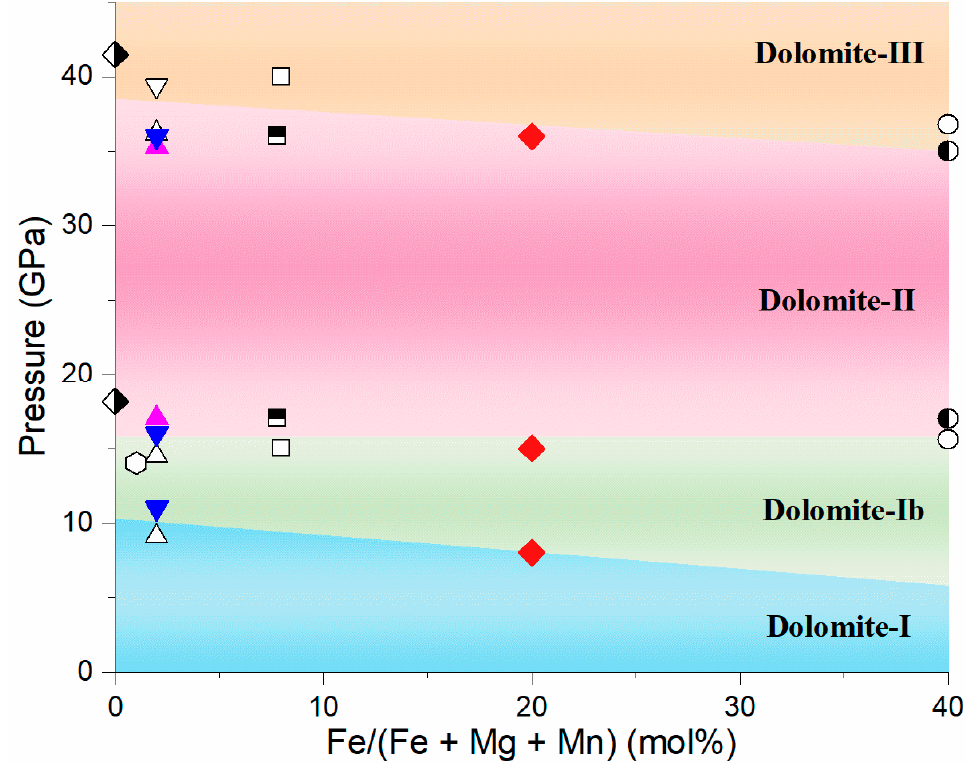
Figure 7. Phase transitions of dolomite as a function of iron content. The cyan, green, magenta, and yellow areas represent the dolomite-Ib, -II, -III phases . Solid red diamonds, : Ca 1.02 Mg 0.76 Fe 0.20 Mn 0.02 (CO 3 ), this study; half open and half solid black diamonds, : CaMg(CO 3 ) 2 [28]; open black hexagon, : Ca 1.001 Mg 0.987 Fe 0.01 Mn 0.002 (CO 3 ) 2 [52]; open black up triangles, : CaMg 0.98 Fe 0.02 (CO 3 ) 2 [25]; open black down triangle, : CaMg 0.98 Fe 0.02 (CO 3 ) 2 [24]; solid magenta triangles, : CaMg 0.98 Fe 0.02 (CO 3 ) 2 [24]; half open and half solid black squares, : Ca 0.988 Mg 0.918 Fe 0.078 Mn 0.016 (CO 3 ) 2 [27]; open black squares, : CaMg 0.92 Fe 0.08 (CO 3 ) 2 [29]; open black circles, : CaMg 0.6 Fe 0.4 (CO 3 ) 2 ; half open and half solid black circles, : CaMg 0.6 Fe 0.4 (CO 3 ) 2 [28].